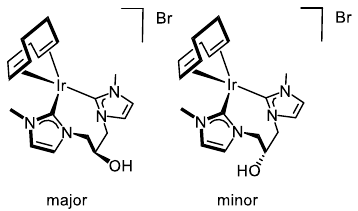
Figure 7. Diastereomers of complex 4